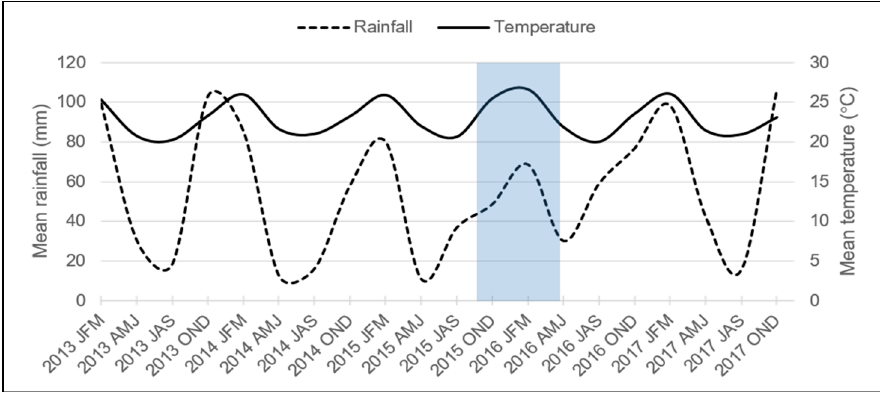
Figure 7. Quarterly mean rainfall and temperature over KwaMbonambi from 2013 to 2017.